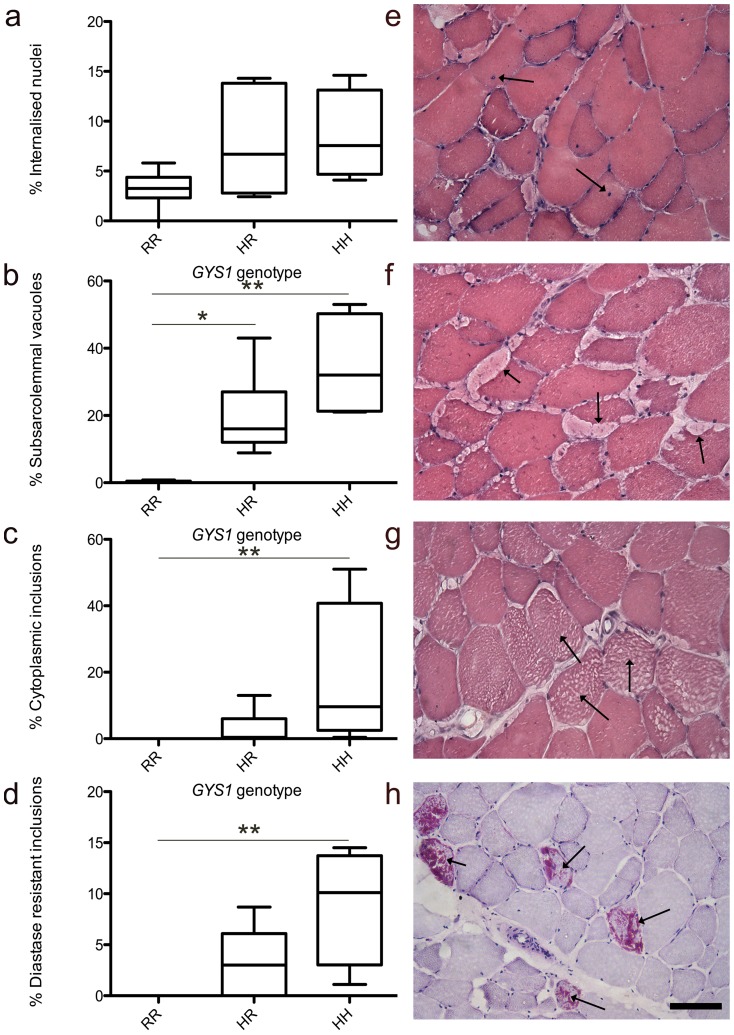
The effect of GYS1 genotype on skeletal muscle histopathology.a–d: Boxplots illustrating the percentage of muscle fibres containing (a) internalised nuclei, (b) subsarcolemmal vacuoles, (c) cytoplasmic inclusions and (d) diastase resistant inclusions in horses homozygous (HH) and heterozygous (HR) for GYS1 mutation and controls (RR). * Denotes significant differences between individual groups (p<0.05), ** (p<0.01), following post- hoc analysis. e–h: Representative images of the pathology (arrows) identified (e) internalized nuclei, (f) subsarcolemmal vacuoles, (g) cytoplasmic inclusions and (h) diastase resistant inclusions (e–g: haematoxylin and eosin; h: Periodic acid Schiff following diastase digestion). Bar = 50 µm.